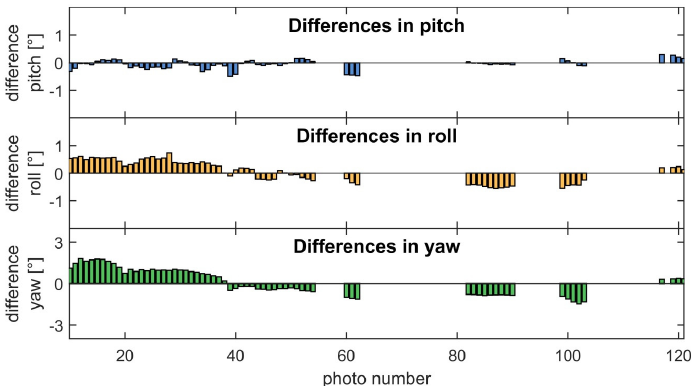
Figure A2. Histogram of differences between the indirect (SfM-computed) angles and those from the GPS/INS from Flight 2 after mounting calibration. The first images acquired during the initial state of GSP/INS are dismissed.